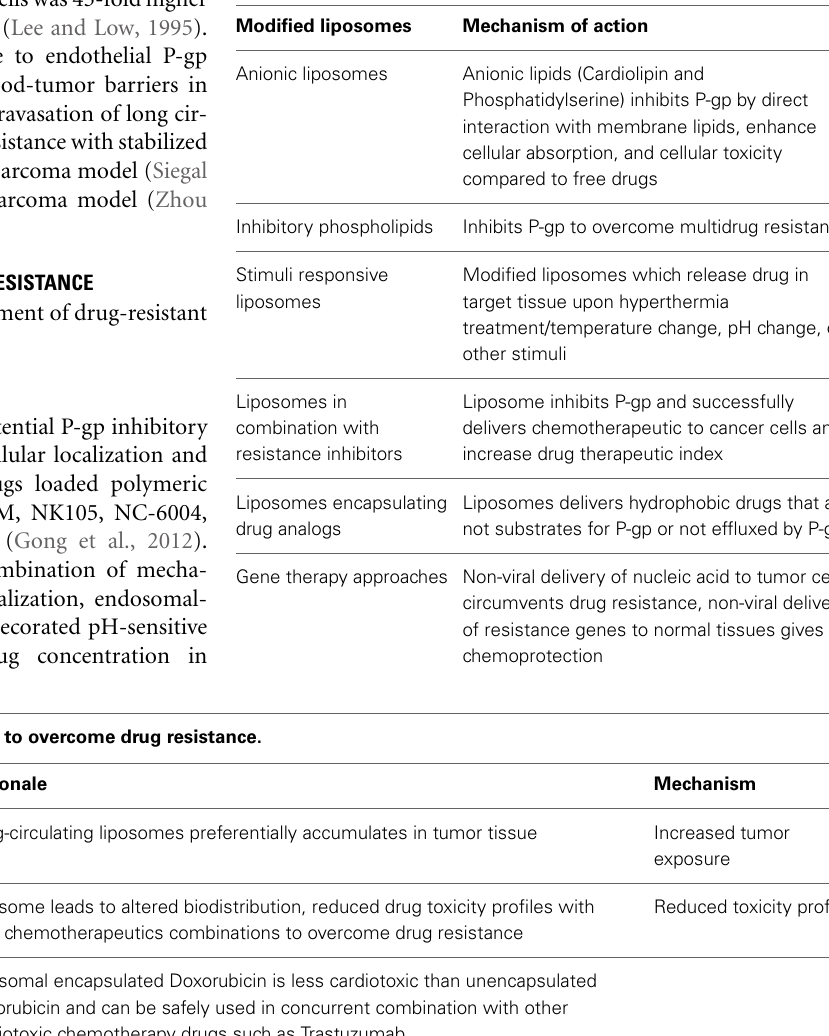
Table 5 | Modified liposome approaches to overcome multidrug resistance.